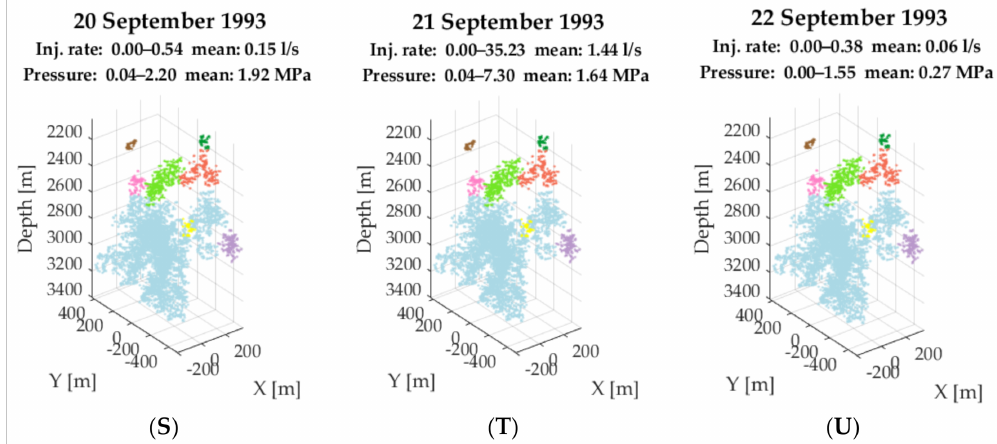
Figure 8. Three-dimensional view of the spatiotemporal evolution of a cumulative collapsed seismic cloud. The colors of events match the colors representing clusters in Figure 7. The minimum, maximum, and mean values for injection rate and wellhead pressure for each day are shown. ( A ) 2.09.1993 ( B ) 3.09.1993 ( C ) 4.09.1993 ( D ) 5.09.1993 ( E ) 6.09.1993 ( F )